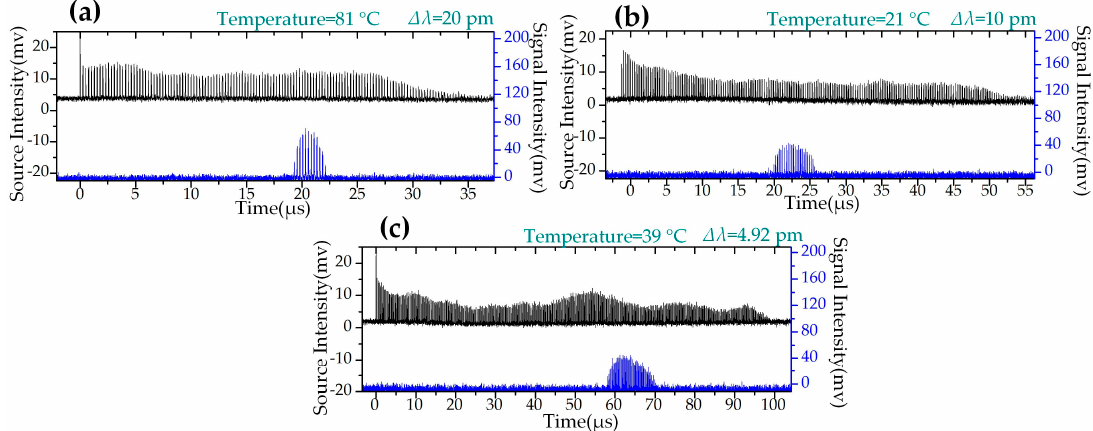
Figure 5. Waveforms of FBG temperature sensing based on WSSL with different sweep steps ( ∆λ ). ( a ) ∆λ = 20 pm and the temperature is 81 °C. ( b ) ∆λ = 10 pm and the temperature is 21 °C. ( c ) ∆λ = 4.92 pm and the temperature is 39 °C.